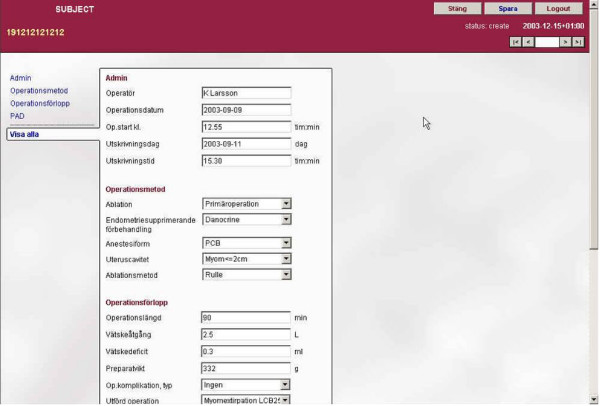
PDS Data Entry Screen.